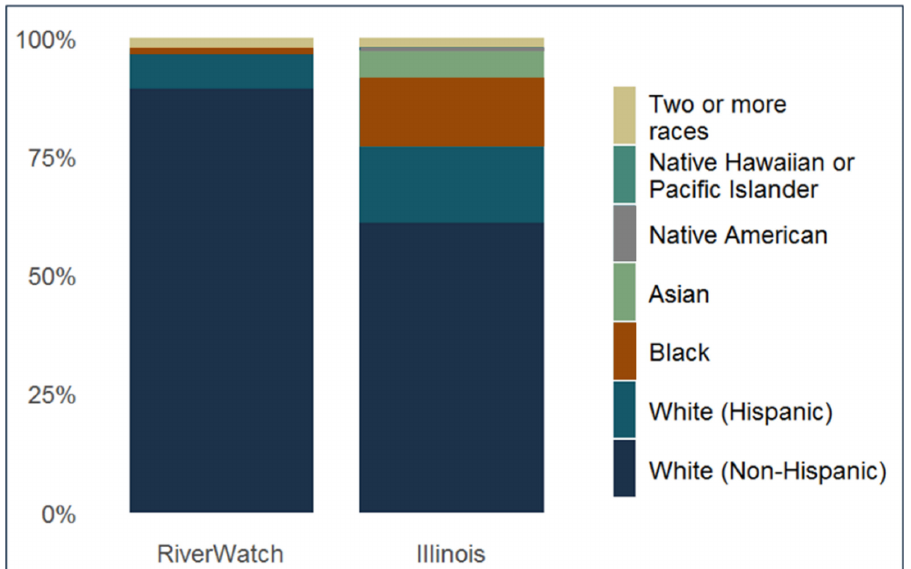
Figure 1: Racial demographics of RiverWatch citizen scientists from participant surveys (N = 94) compared with the demographics of the Illinois population as a whole from the American Community Survey